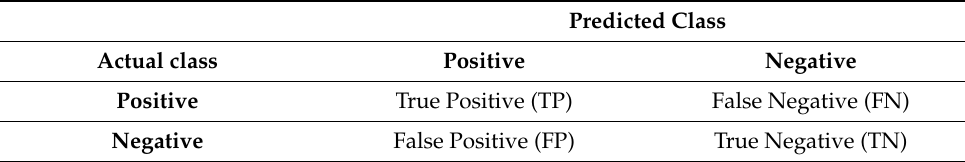
Table 2. Confusion